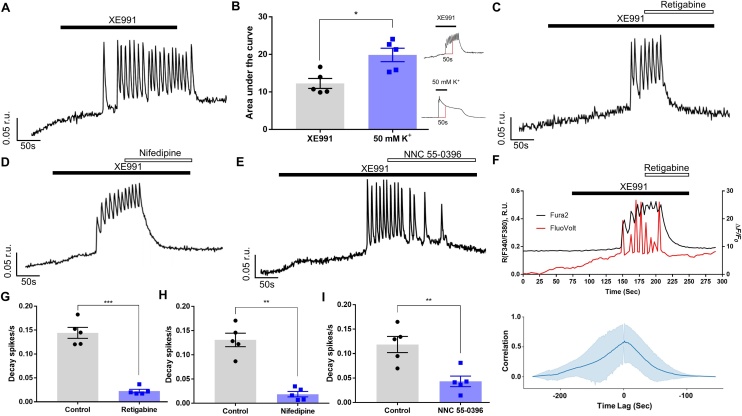
Kv7 channel inhibition induces Ca2+ oscillations linked to L- and T-type VGCCs activity. (A) Representative example trace showing Ca2+ oscillations (indicated as F340/F380 ratio units; r.u.) evoked by Kv7 channel inhibitor XE991 (10 μM). (B) Comparison of amplitude of Ca2+ signals induced by XE991 and 50 mM K+, estimated as area under the curve during first 50 s of stimulus application (corresponding to the duration of high-K+ stimulation; exemplified in the inset on the right). (C-E) Example traces of XE991-induced Ca2+ transients recorded in the presence of Kv7 channel opener, retigabine (10 μM; C), L-type (nifedipine; 2 μM; D) or T-type (NNC 55-0396; 3 μM; E) Ca2+ channel blockers (as indicated). (F) Upper panel: superimposed are Fura2 ratiometric Ca2+ recording (black) and FuoVolt membrane potential recording (measured as ΔF/F0; red) during application of XE991 (10 μM) and retigabine (10 μM) during periods indicated by horizontal bars. Lower panel: Cross correlation of the normalised ratiometric Ca2+ signal with the normalised FluoVolt signal indicated the time lag between the signals at which the peak correlation occurred. (G-I) Bar graphs summarising the effects of retigabine (G), nifedipine (H) or NNC 55-0396 (I) on the XE991-induced Ca2+ spike frequency (spikes/s). Control is the spike frequency in the presence of XE991 measured from the onset of the first spike. For quantification of drug effect spike frequency was calculated from the onset of the drug application and until the end of the application of XE991. In panels G-I data are presented as mean ± S.E.M.; **P < 0.01, ***P < 0.001 (n = 5).